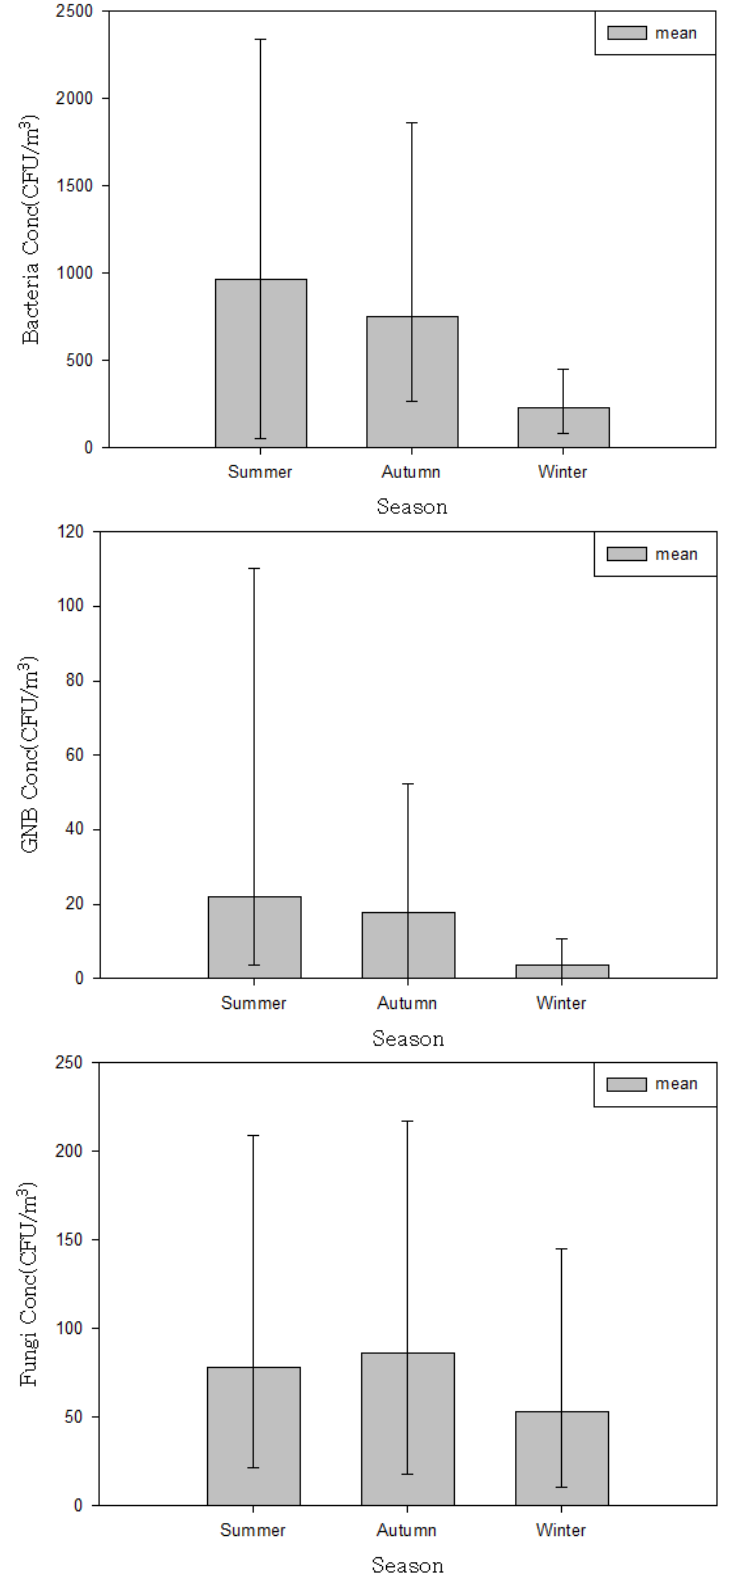
Figure 2. Variation in airborne microorganism concentrations by